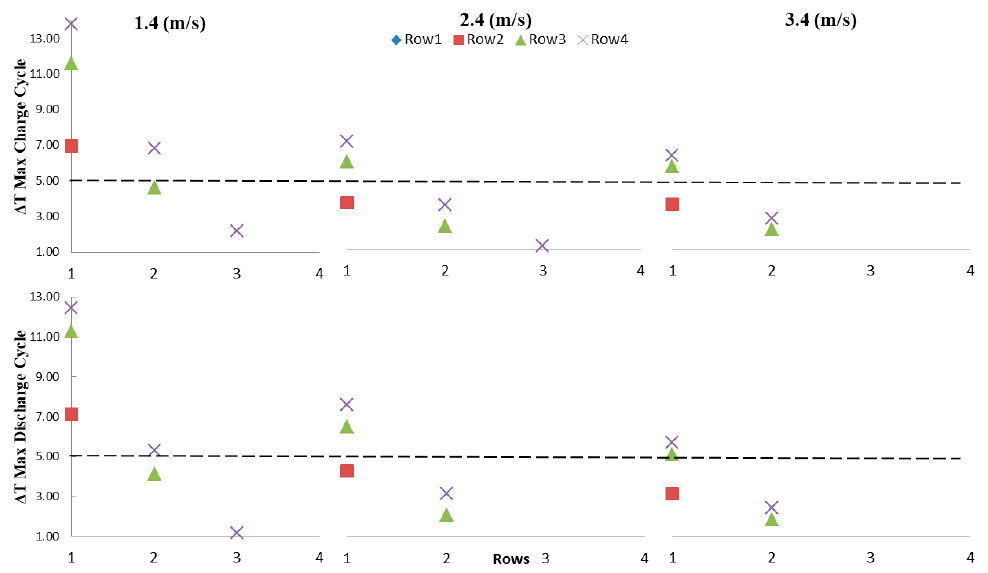
Figure 18. Effects of air flow rate on temperature differences (0.75 C).